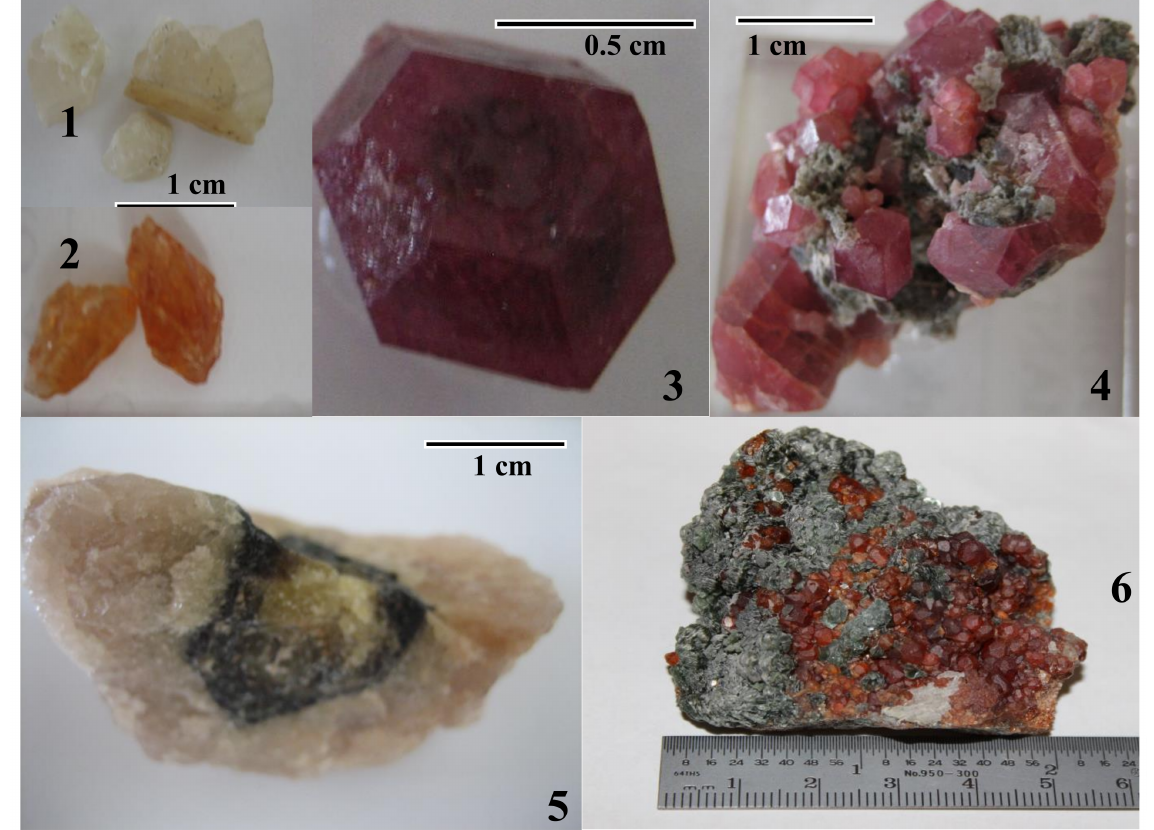
Figure 2. Samples used in this study are ( 1 ) “white jade” from Lytton, British Columbia, Canada; ( 2 ) orange-brown “hessonite” grossular from Tanzania; ( 3 ) euhedral crystals of raspberry-red grossular from Coahuila, Mexico; ( 4 ) deep-pink grossular from Chihuahua, Mexico; ( 5 ) grossular from Chihuahua, Mexico with a yellow core and a creamy-white outer layer. The dark material between the yellow and white parts is andradite. Both the white and yellow parts were used in this study. ( 6 ) Well-developed euhedral crystals of red grossular from Aosta,